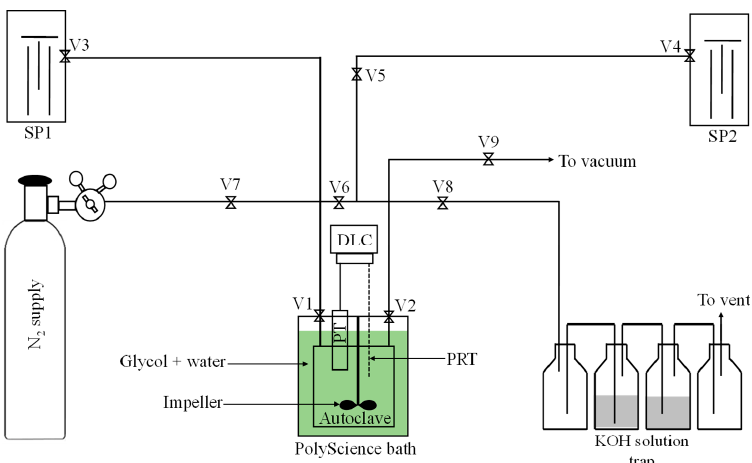
Figure 1. Schematic diagram of the setup for the measurement of H 2 S hydrate dissociation in the presence of liquid water. V1, V2, DLC, and PT represent the inlet valve, outlet valve, data logging computer, and pressure transducer, respectively. V3, V4, V5, V6, V7, V8, and V9 represent control valves. SP1 is a high-pressure syringe pump containing degassed water, and SP2 is the high-pressure syringe pump containing H 2 S